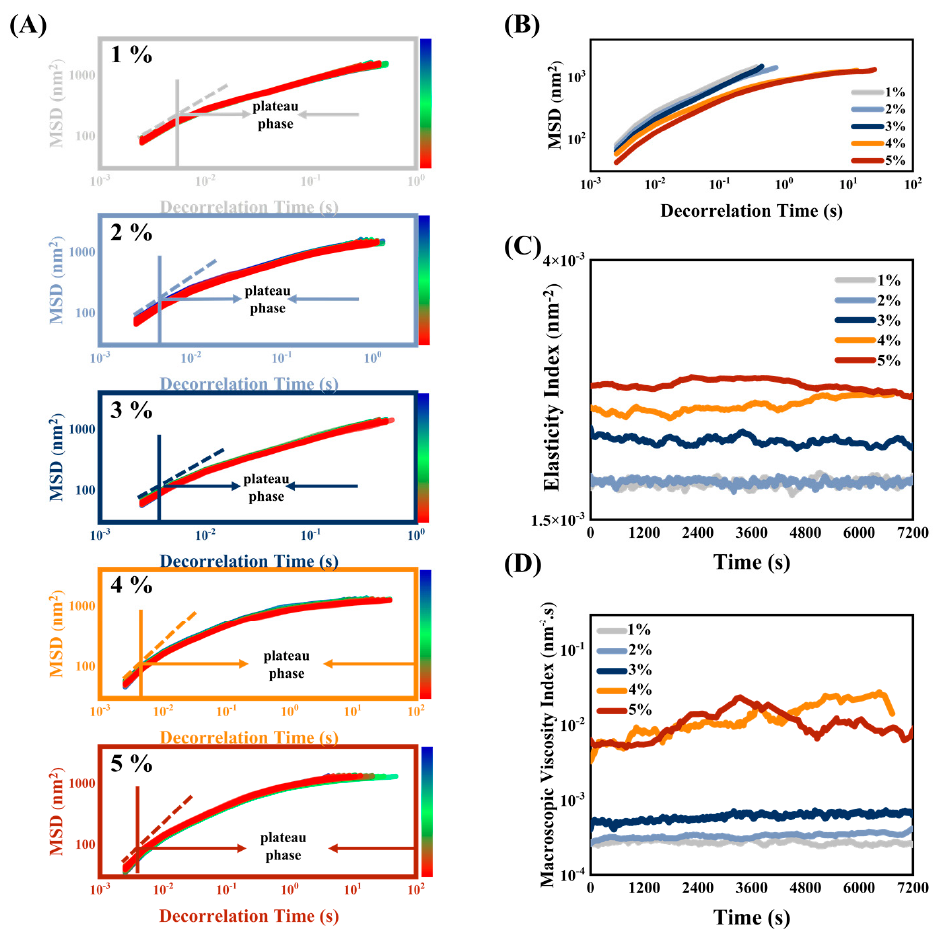
Figure 4. ( A ) Mean-square displacement scanning curve and ( B ) single mean-square displacement single scanning curve at 1 h of HIPEs stabilized by 1–5 wt% MPPI. ( C ) Elasticity index and ( D ) macroscopic viscosity index of HIPEs stabilized by 1–5 wt% MPPI.